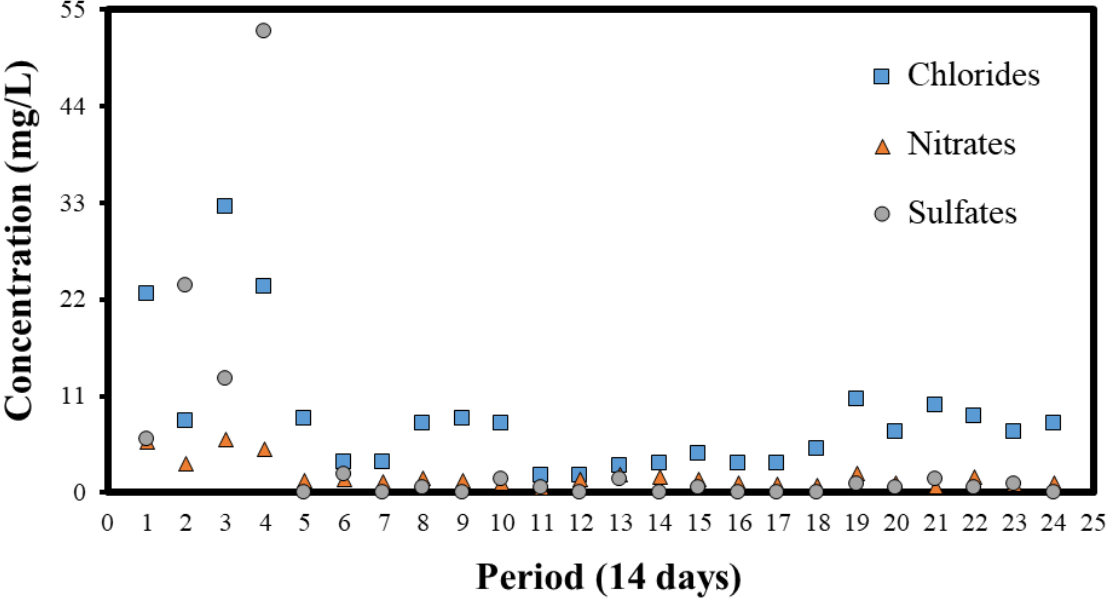
Figure 8. Behavior of the concentration of major anions in the rainwater of the basic geostatistical area 2736, year 2021.